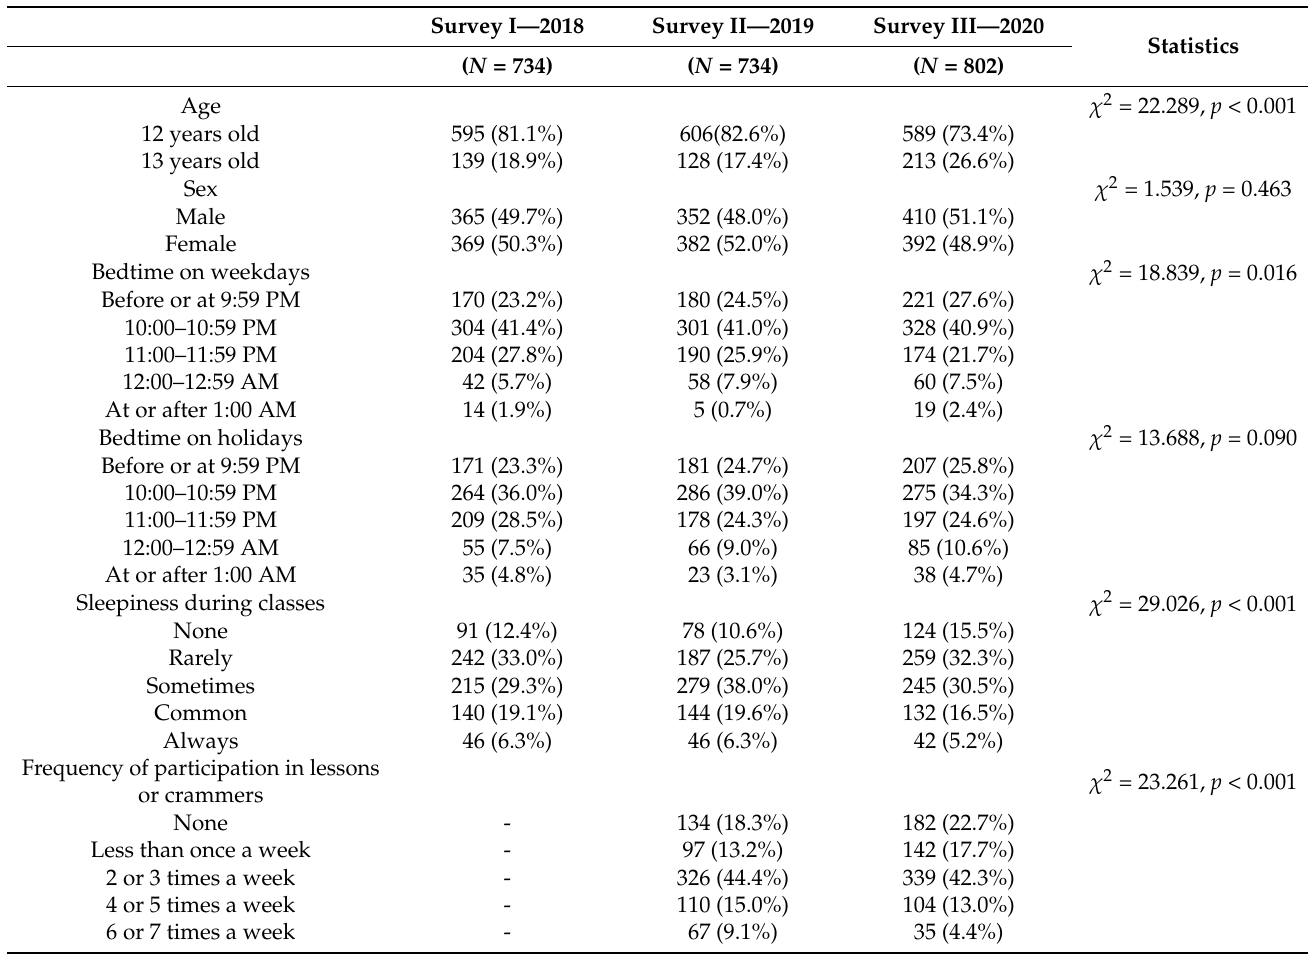
Table 1. Comparisons of age, sex, bedtime, sleepiness during classes, and frequency of participation in lessons or crammers between the surveys.